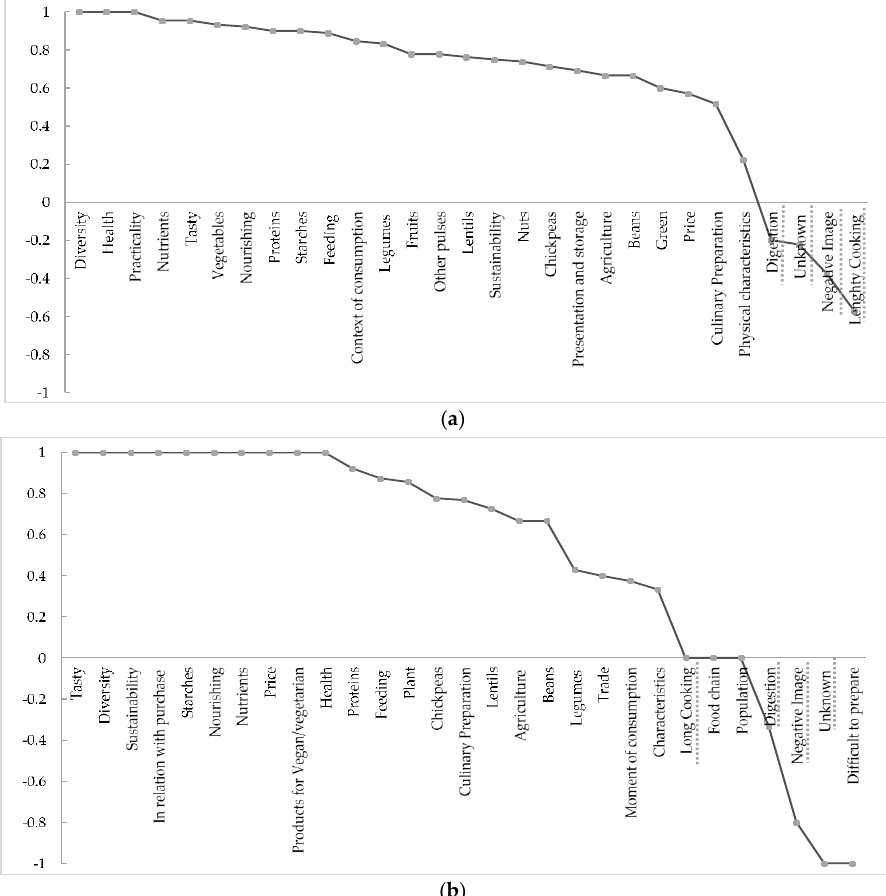
Figure 2. Polarity Index for French nonvegetarian consumers ( a ), and for professionals ( b ). The word groups underlined with a dotted line are common to both consumers and professionals, with either neutral or negative valence.